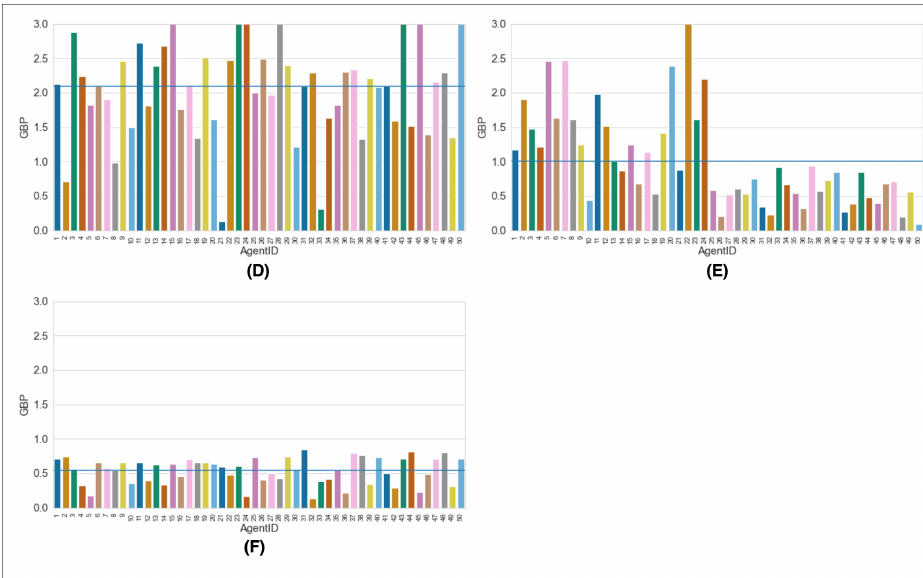
Figure A4. The total sum of petrol costs (GBP) for each ICEV, model conditions 4 to 6. Where ( D ):